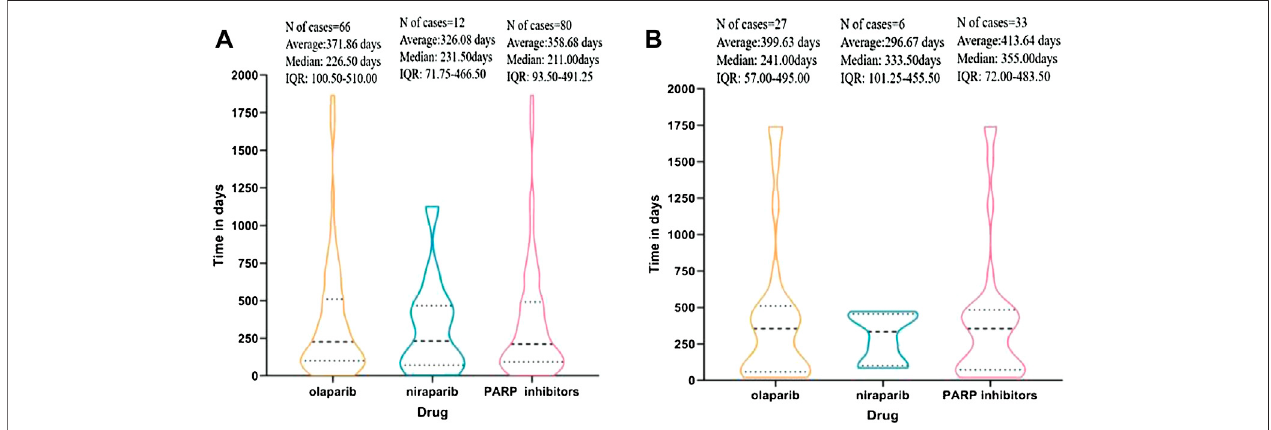
FIGURE 1 | (A) Time to event onset of myelodysplastic syndrome (MDS) following olaparib and niraparib. (B) Time to event onset of acute myeloid leukemia (AML) following olaparib and niraparib. Data on rucaparib and talazoparib are not available since the missing data (number of cases < 4).